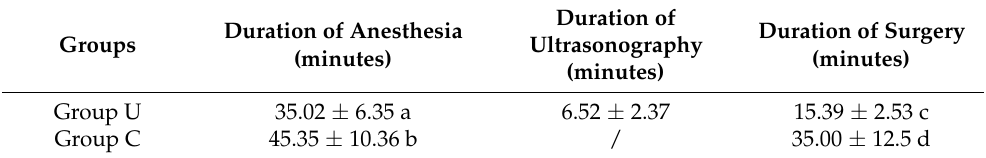
Table 1. Duration of anaesthesia, ultrasonography, and surgery in Group U (pigs underwent ultra- sound examination before cryptorchidectomy) and Group C (control group, without ultrasonography). In column: a,b: p < 0.05; c,d: p <